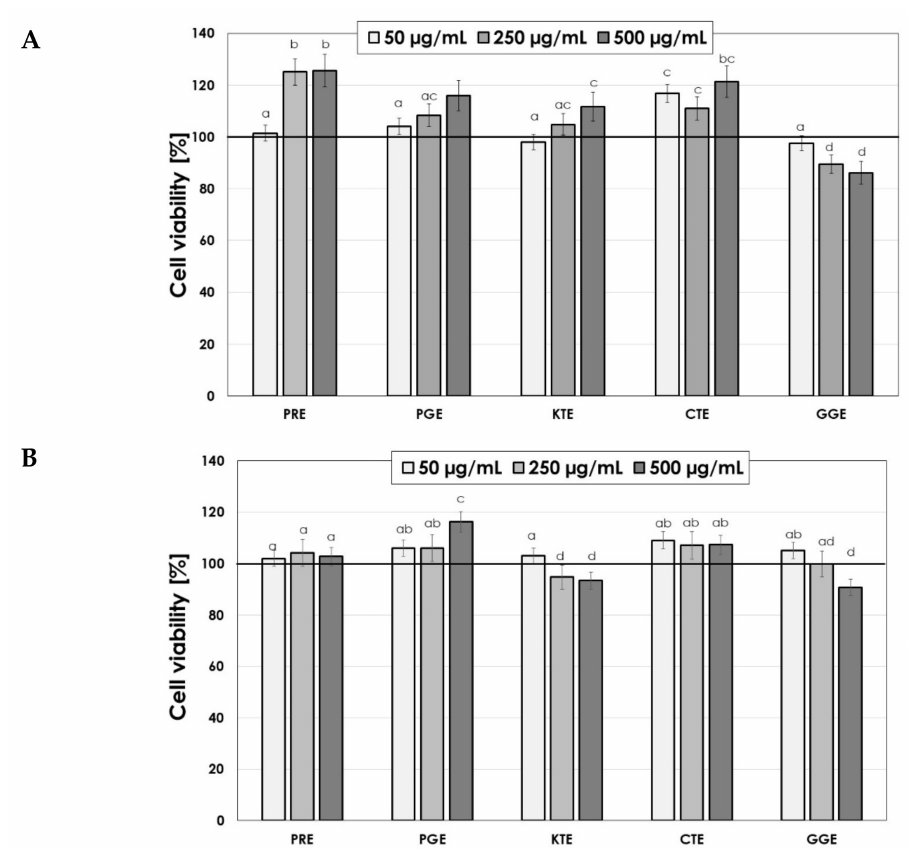
Figure 6. The reduction in resazurin after 24-h exposure to PRE, PGE, KTE, CTE and GGE extracts in cultured fibroblasts ( A ) and keratinocytes ( B ). Data are the mean ± SD of three independent experiments each consisting of four replicates per test